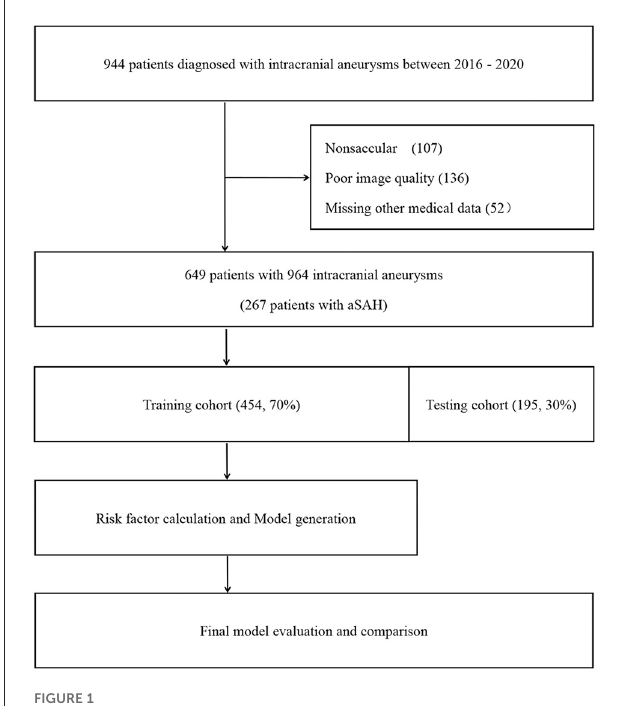
FIGURE1 Study flow diagram. aSAH, aneurysmal subarachnoid